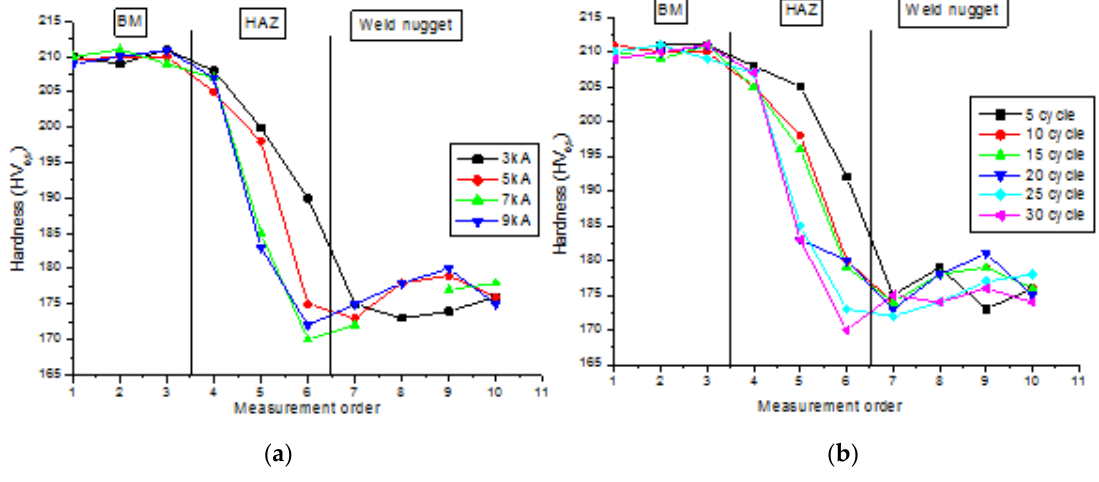
Figure 6. The hardness of weldment versus: ( a ) welding current; and ( b ) welding time.